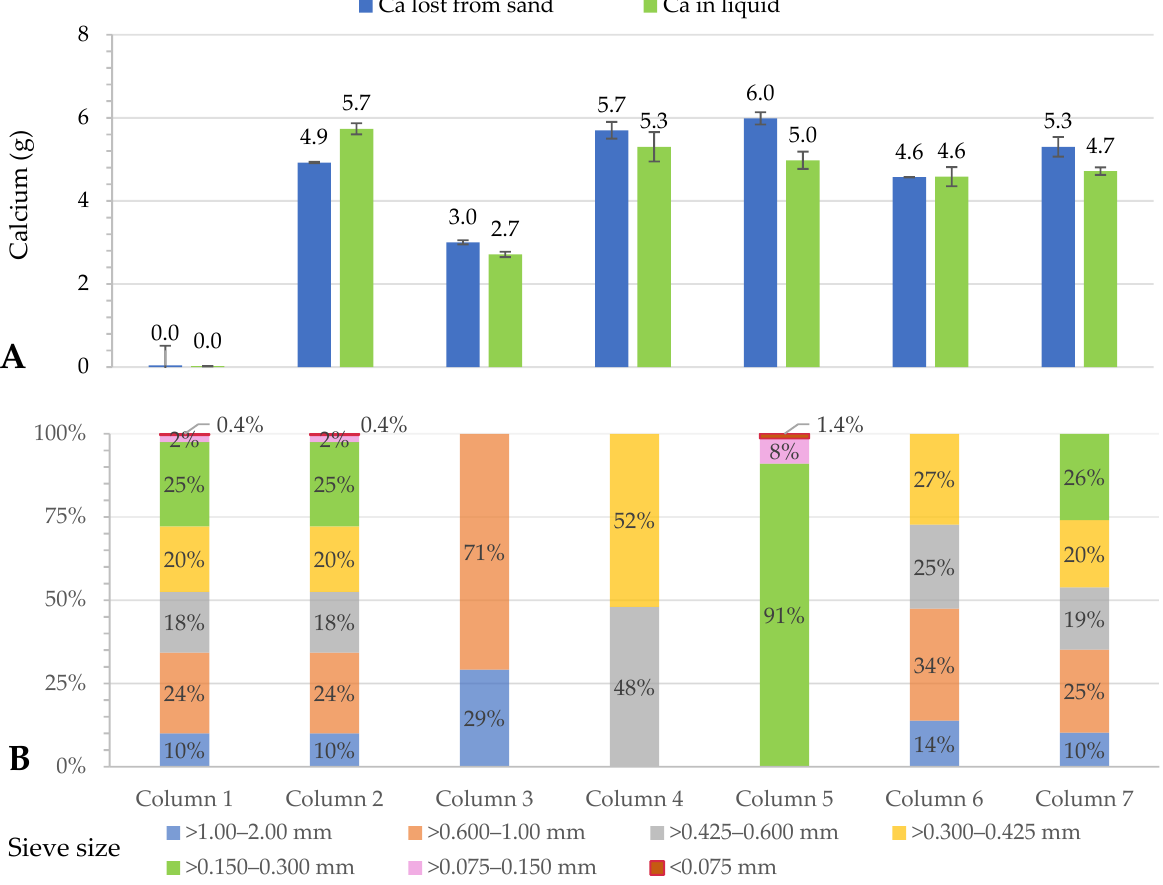
Figure 4. Daily effluent pH measurements used to compare neutralization efficiencies and end- points.